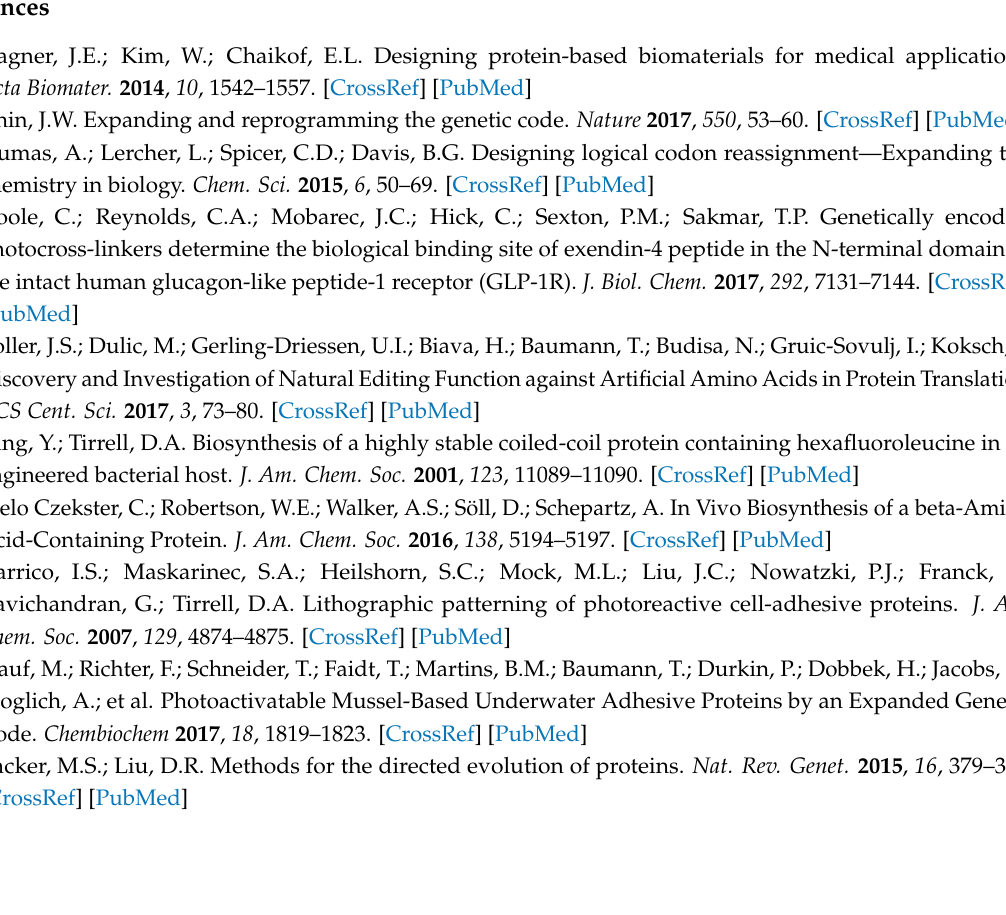
Figure S6: Quantification of the shifted bands corresponding to Sep-GFP yields observed in presence of increased amounts of MiaA and TruB. Table S1: List of Keio knockout strains employed in this study. Table S2: Plasmids used in this study. Table S3: Statistical analysis of the sfGFP-2TAG synthesis in the Keio deletion strains in presence of Sep-OTS. Table S4: Statistical analysis of the sfGFP-2TAG synthesis in the Keio deletion strains in presence of tRNA Sep/G37A . Table S5: Statistical analysis of the sfGFP synthesis in the Keio deletion